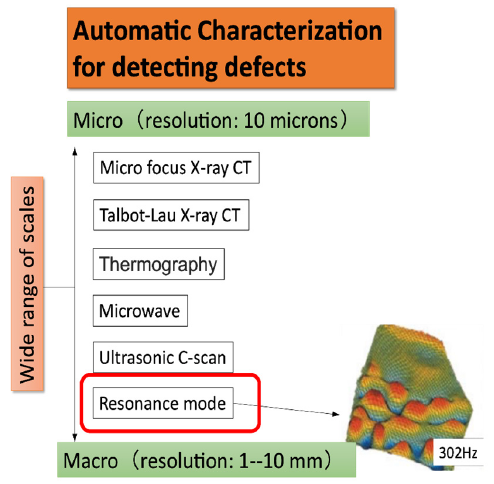
Figure 1. Target resolution for NDE using vibration/resonance modes.